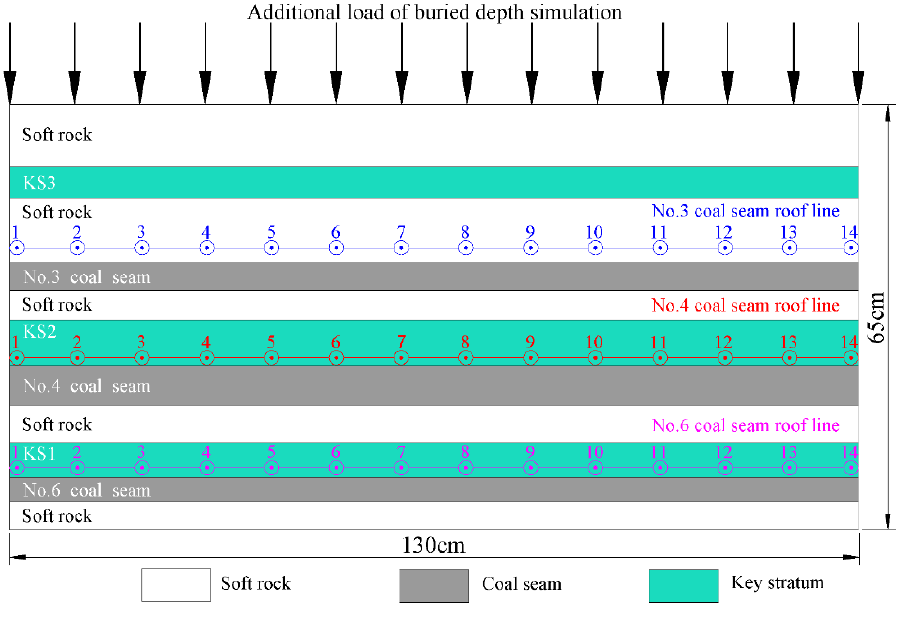
Figure 7. Schematic diagram of similar simulation model.